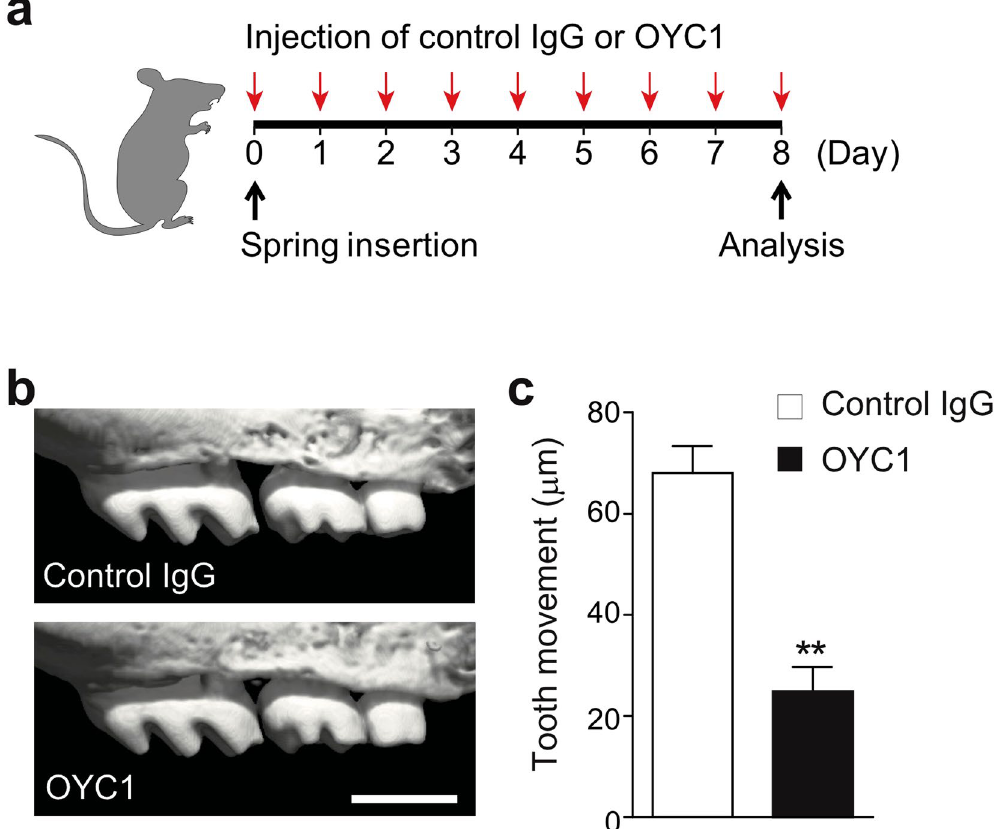
Figure 2. Effect of anti-mouse RANKL monoclonal antibody (OYC1) on tooth movement. ( a ) Schematic diagram of the injection time course. OYC1 or control IgG was injected locally into the buccal and palatal gingiva around the upper left first molar of wild-type mice. ( b ) Representative micro-CT images of a moved tooth after treatment of OYC1 or control IgG. ( c ) Quantification of tooth movement in each group (n = 3–4). Error bars, means ± s.e.m.; ** P <